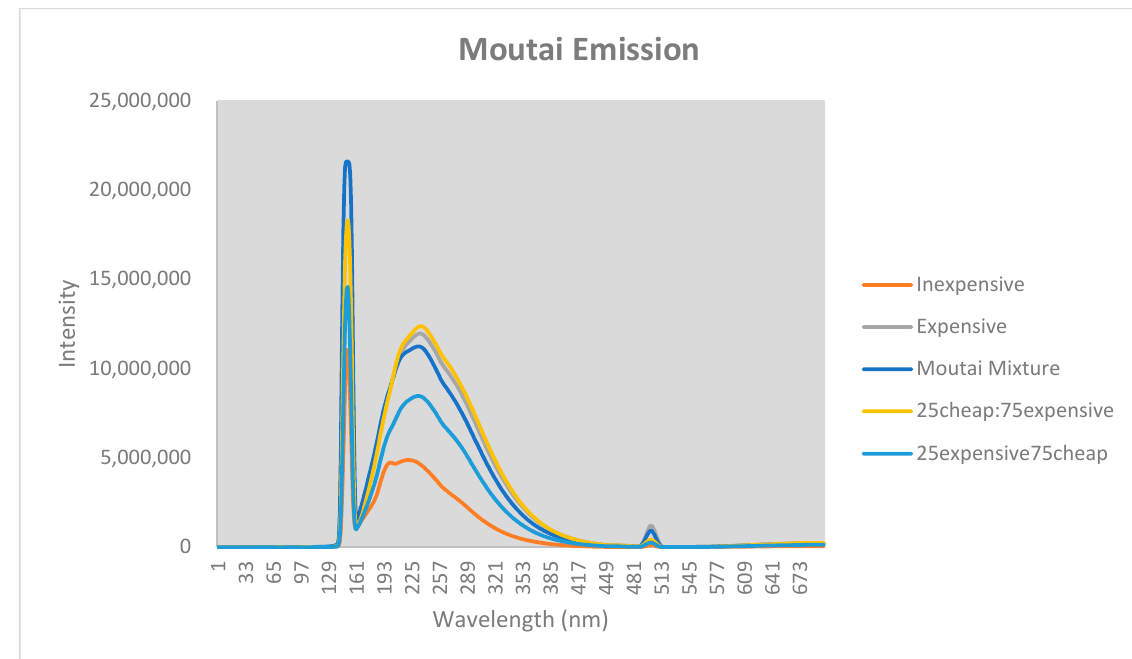
Figure 5. Moutai emission of different ratios of inexpensive to expensive baijiu spirits.